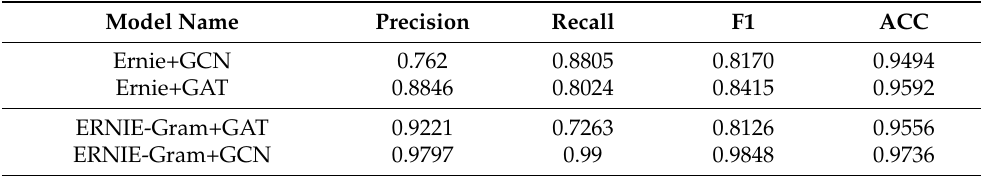
Table 6. Comparison of GAT and GCN on